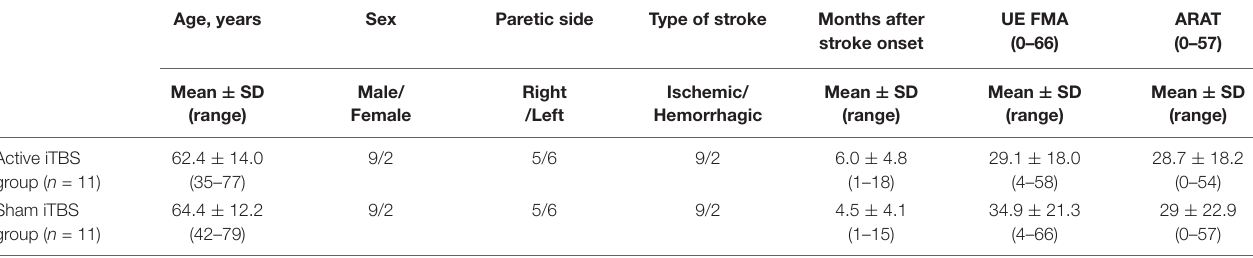
TABLE 1 | Patients’ demographic and clinical